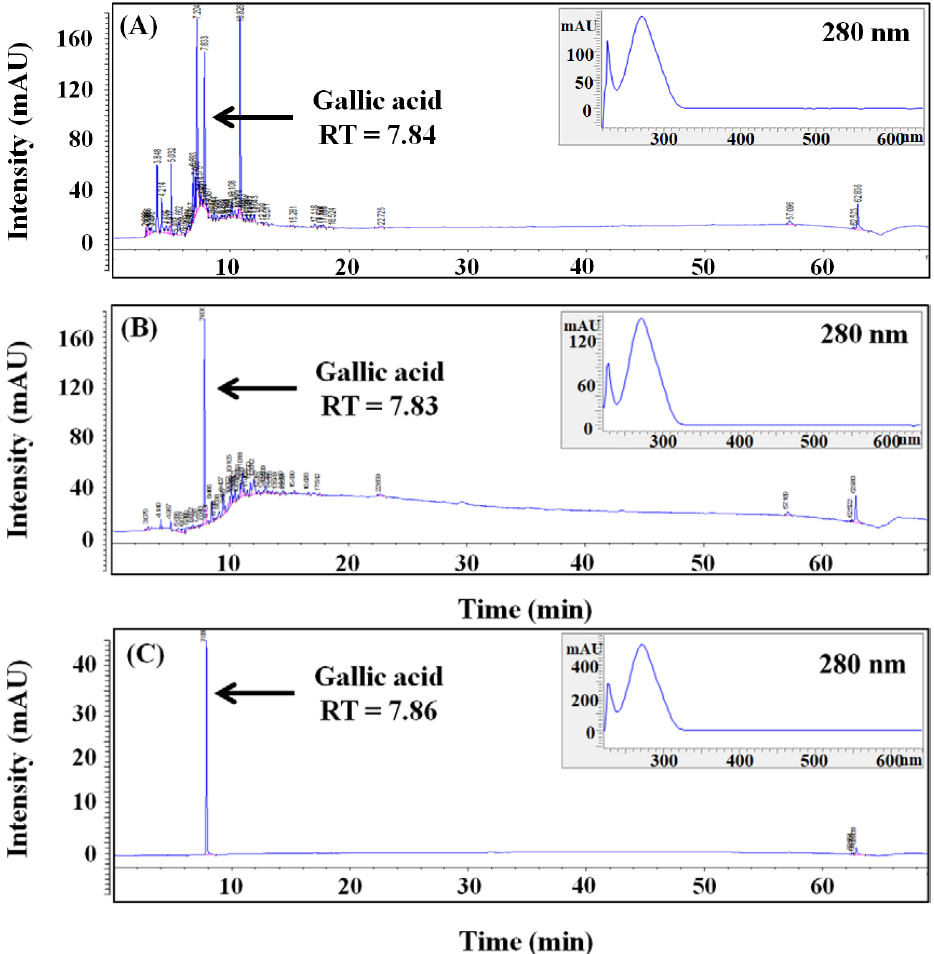
Figure 6. HPLC chromatograms for quantitative and qualitative analysis for the determination of gallic acid in UCS and BCS. Chromatogram and DAD spectrum (190–640 nm) of gallic acid from UCS ( A ) and BCS ( B ). Chromatogram and DAD spectrum (190–640 nm) of gallic acid standard ( C , 0.1 mg/mL). UCS: ultrasound-assisted extracts of chestnut inner shell; BCS: bioconverted chestnut inner shell extracts.